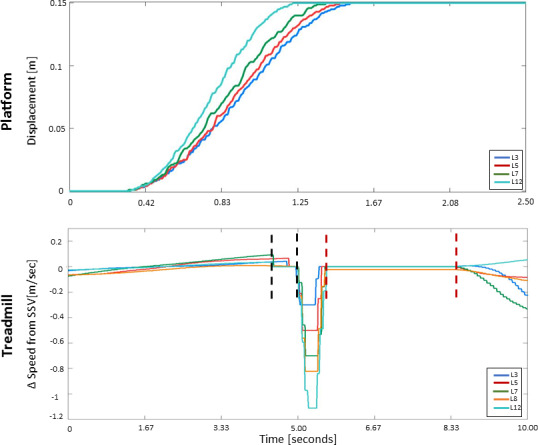
Perturbation profiles used in the platform (top) and treadmill (bottom) experiments.